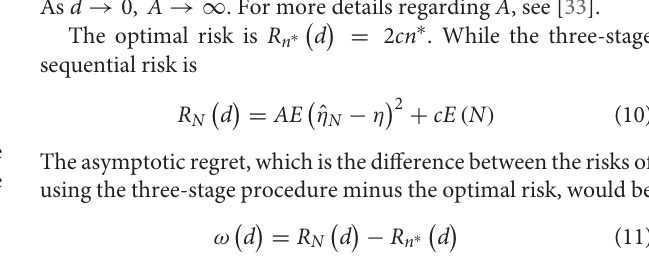
,5, 20 ,10, 20, γ 3 3